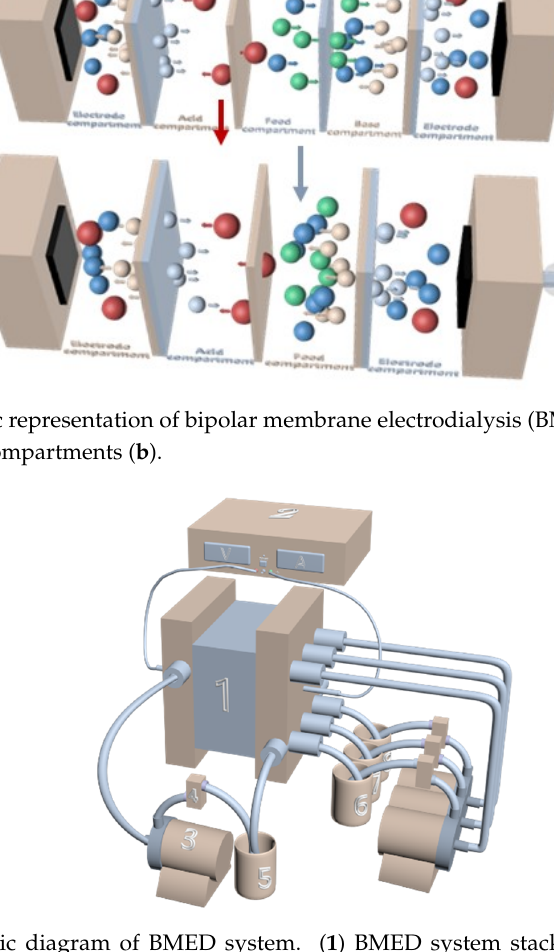
Figure 2. Schematic diagram of BMED system. ( 1 ) BMED system stack; ( 2 ) DC power supply; ( 3 ) centrifugal pump; ( 4 ) rotameter; ( 5 ) electrode rinse tank; ( 6 ) base solution tank; ( 7 ) feed solution tank; ( 8 ) acid solution tank.